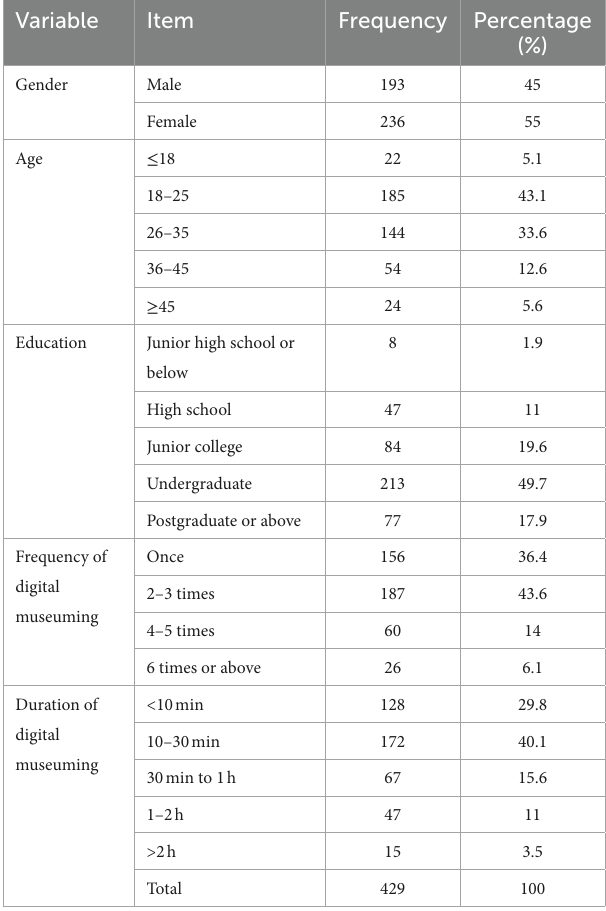
TABLE 1 Demographic characteristics of the